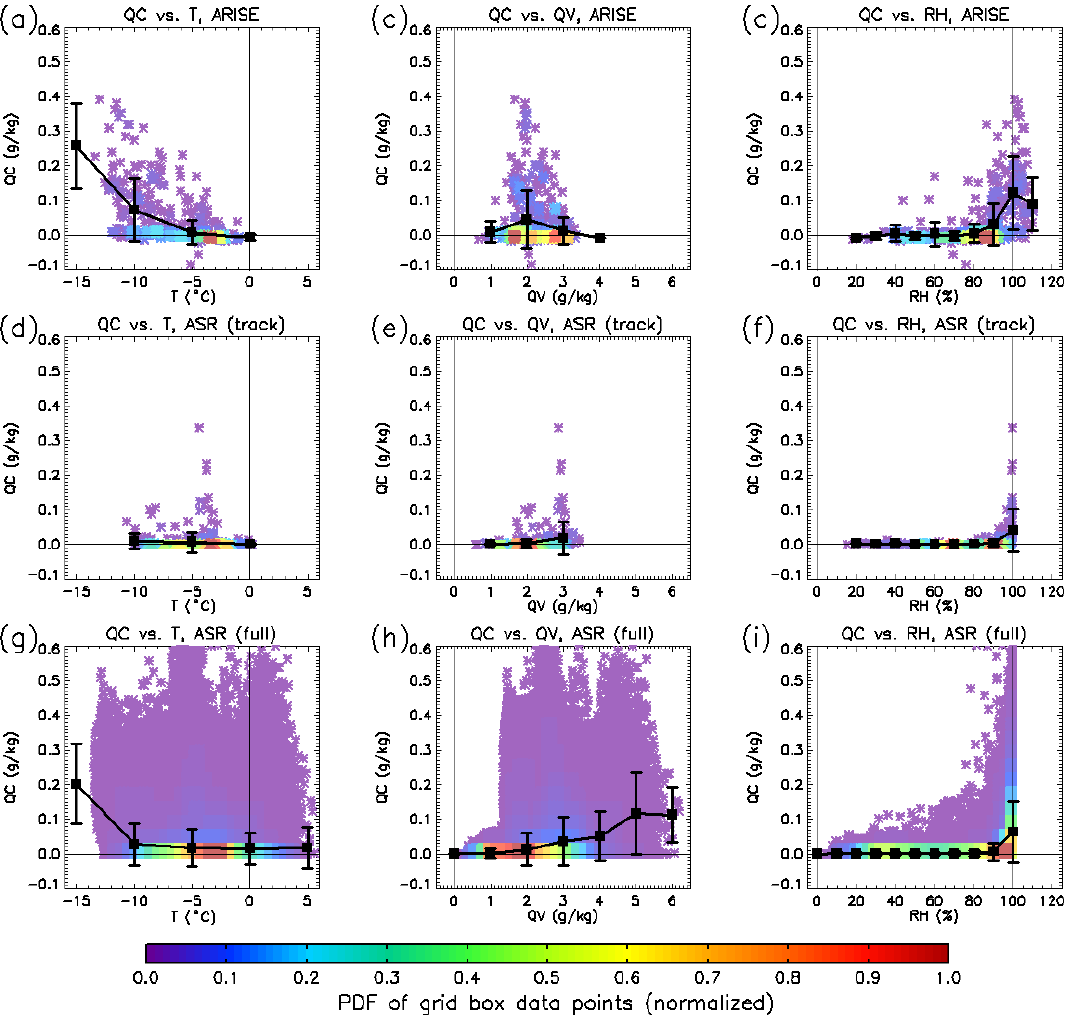
Figure 6. (a–c) Scatterplots of cloud water (QC) versus (a) temperature ( T ), (b) specific humidity (QV), and (c) relative humidity (RH) for ARISE low-altitude observations. The coloration indicates the two-dimensional PDFs of the individual data points (normalized so the max value equals 1). The heavy black line is the linear regression line of best fit. (d–f) Same as (a–c) , but for ASR-simulated variables along the ARISE flight path. (g–i) Same as (a–c) , but for ASR-simulated variables over the full Beaufort Sea